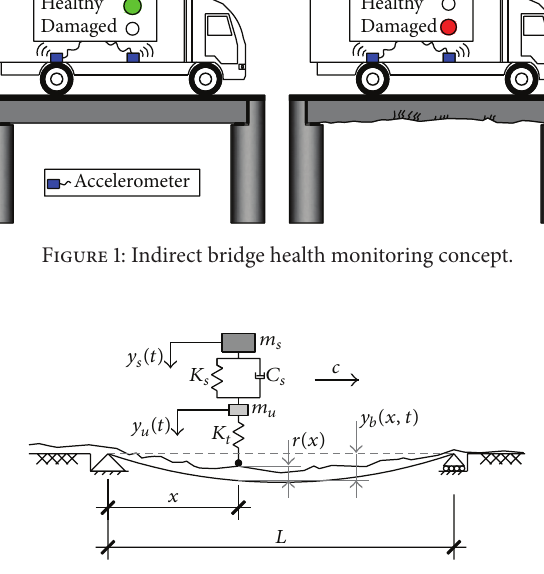
Figure 2: Quarter-car vehicle-bridge interaction